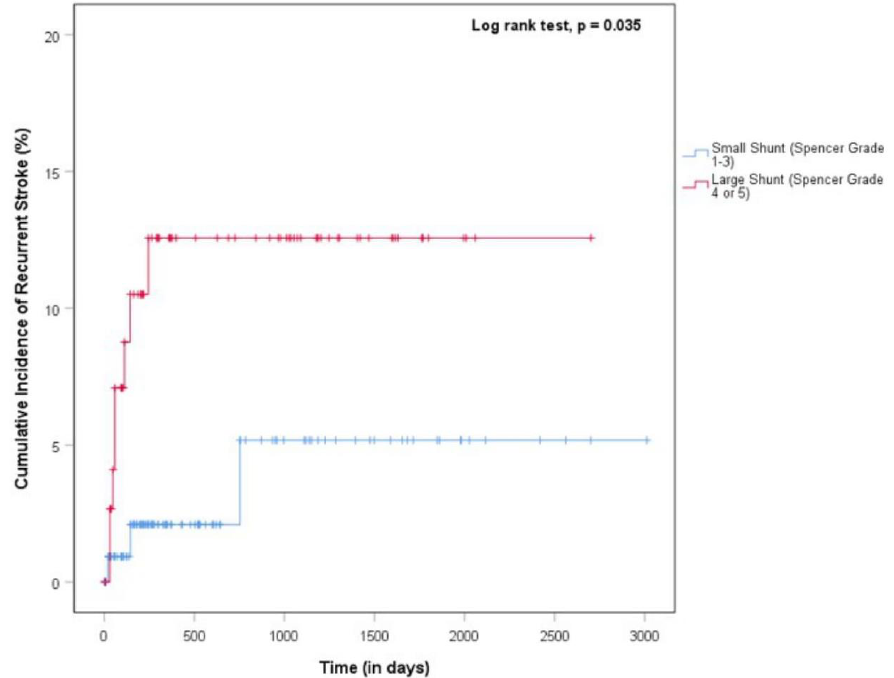
Figure 2. Kaplan–Meier curve comparing cumulative incidence of recurrent stroke between large (Spencer grade 4 or 5) and small (Spencer grade 1, 2, or 3) PFO shunts in patients concomitant cryptogenic stroke.